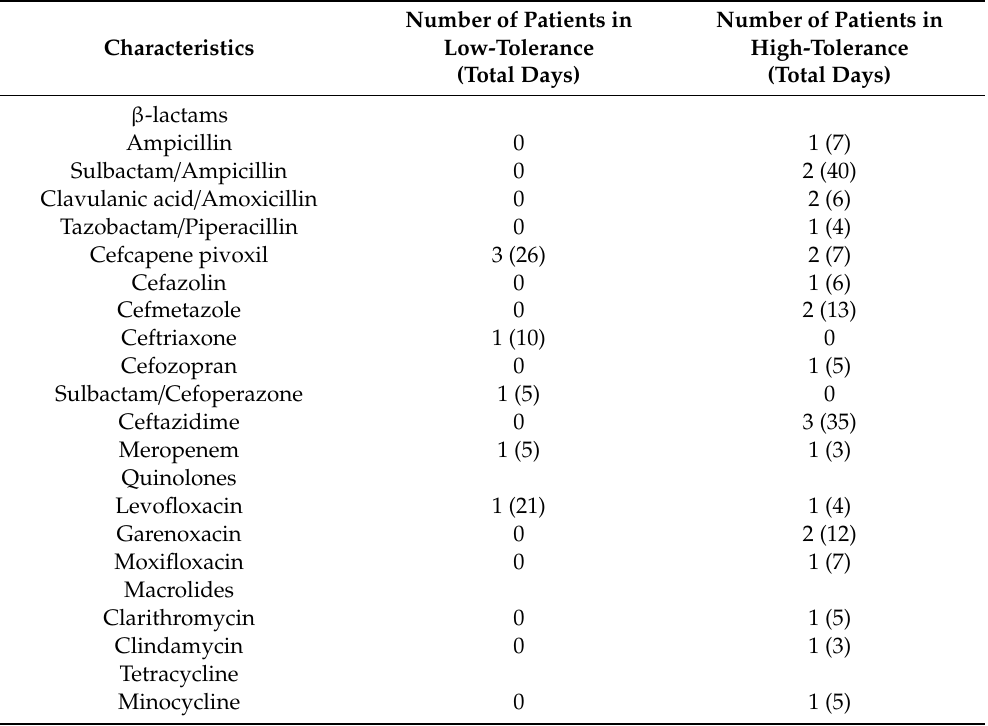
Table 2. History of